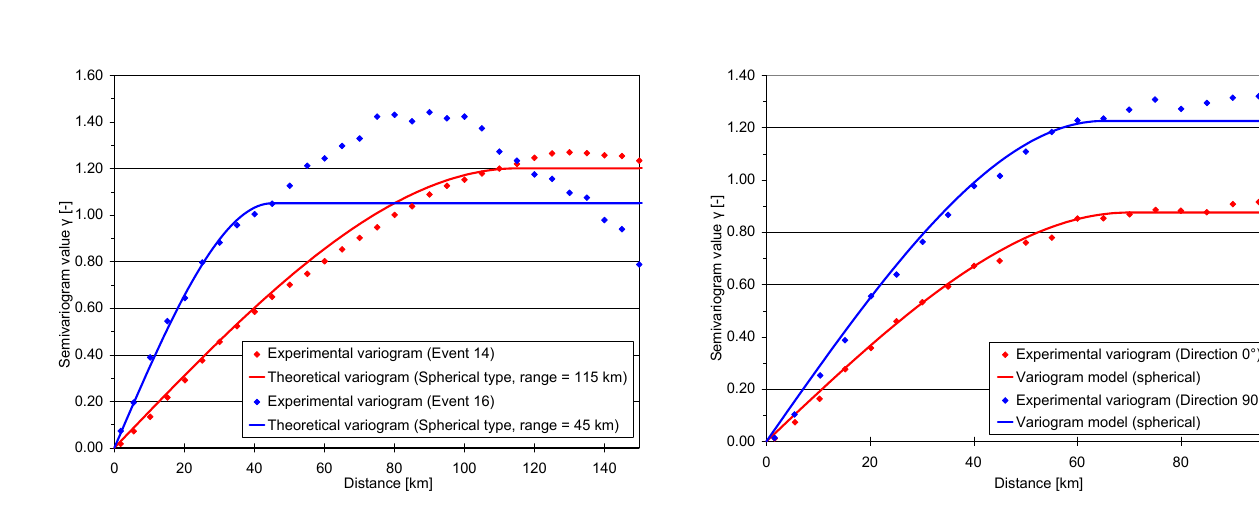
Fig. 3. Directional experimental and theoretical semivariograms for event 9 showing zonal anisotropy (0 ◦ : north-south; 90 ◦ :